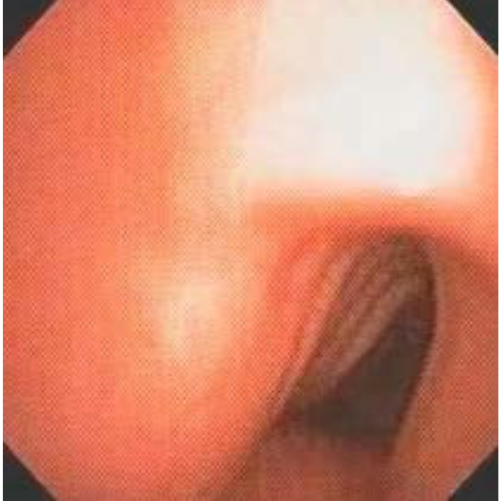
Figure 4. Proximal tracheal deformity in a MPS IV-A patient from the sample.